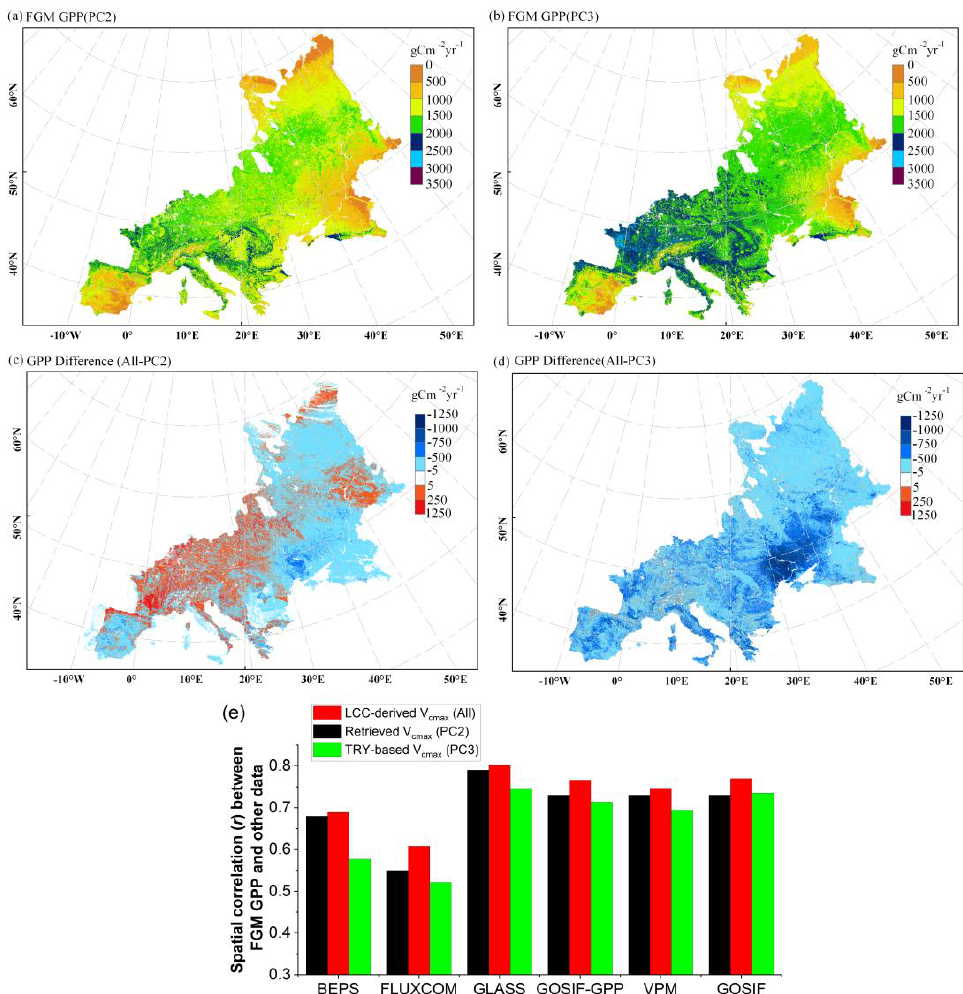
Figure 9. Spatial pattern of mean annual GPP (g C m − 2 yr − 1 ) when V cmax was parameterized in the FGM as a PFT-specific constant with two types of data: ( a ) calibrated V cmax (“PC2”) and ( b ) TRY-based V cmax (“PC3”). ( c ) and ( d ) represent the differences in GPP due to the different V cmax parameterizations, i.e., GPP in “All” minus GPP in ( a ) and ( b ). ( e ) Spatial correlation (r) between the FGM GPP for three different simulations (“All”, “PC2”, and “PC3”) and other GPP products (including BEPS, FLUXCOM, GLASS, and GOSIF GPP products) and GOSIF data.